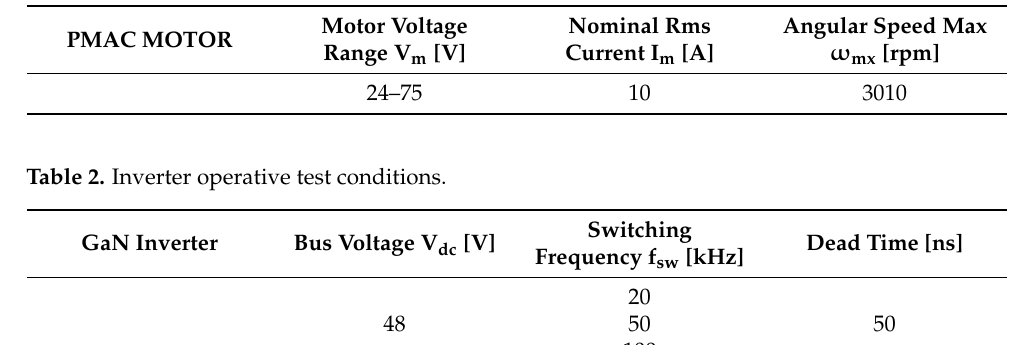
Table 1. Electric motor main characteristics.